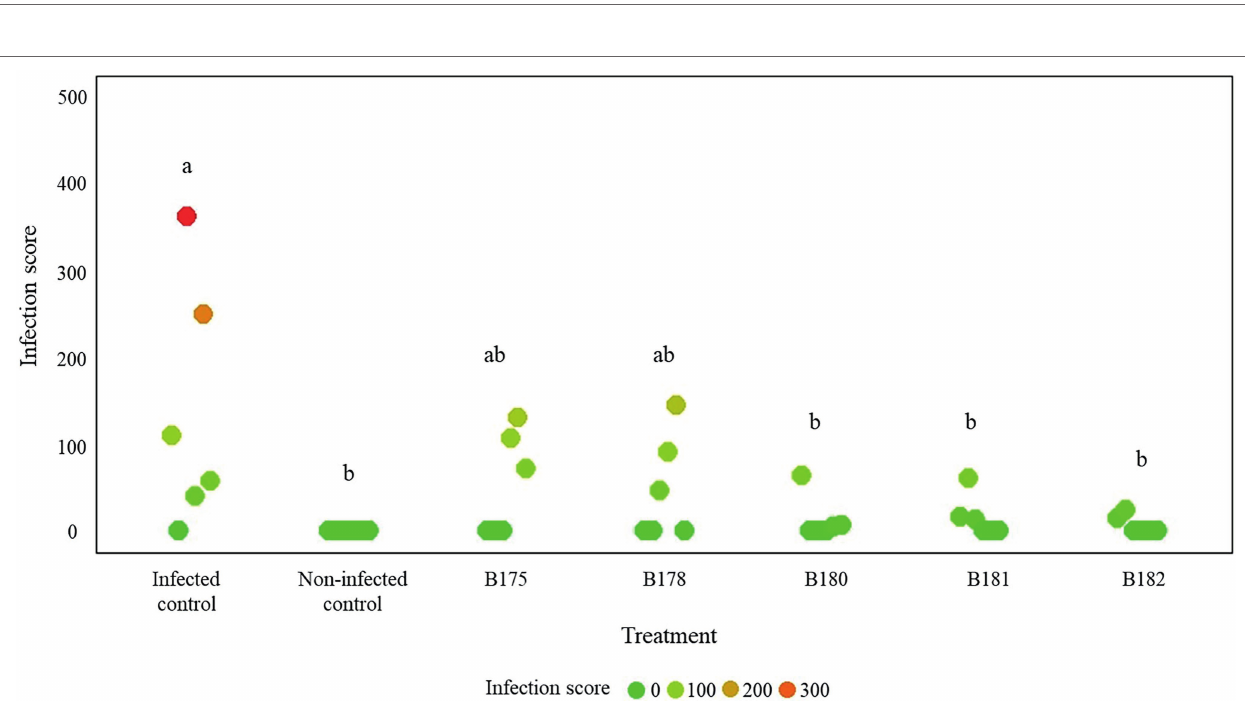
FIGURE 6 | Results of a full plant infection assay on greenhouse-grown potato plants treated with Streptomyces spores and infected with Phytophthora infestans zoospores. The infection assay was carried out on three plants per treatment in two independent experiments. Infection was assessed 14 days after infection and scores were calculated according to the procedure detailed in section “Materials and Methods” and illustrated in Supplementary Figure S1 . Letters indicate significant differences between treatments according to ANOVA followed by Tukey’s honestly significant difference (HSD) tests ( p <